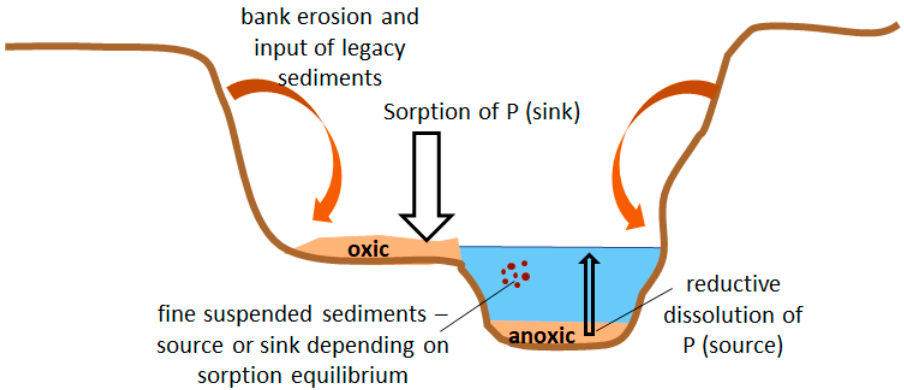
Figure 6. Conceptual model illustrating how stream bank legacy sediments could act as either a source or sink for P at various fluvial positions. Sorption (P sink) could occur on oxygenated floodplains if sediment EPC 0 values are below stream water P concentrations. In contrast, sediments could become a source of P due to reductive dissolution of iron oxides under anoxic conditions or when EPC 0 values are greater than stream water P concentrations. Deposition of legacy sediments in the channel could occur due to fluvial and/or subaerial bank erosion or mass wasting of the bank material.